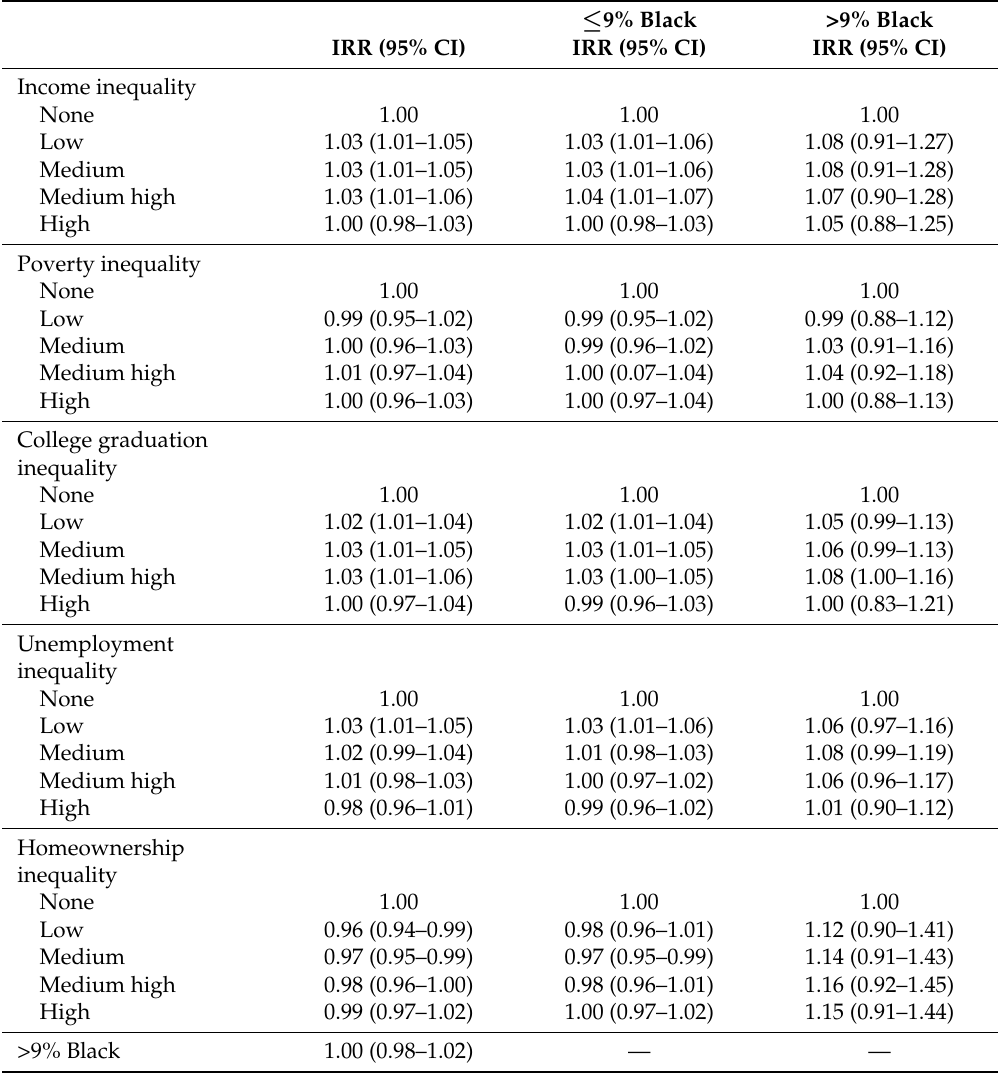
Table 4. Associations between indicators of structural racism and fast food by racial composition in U.S. county-years,